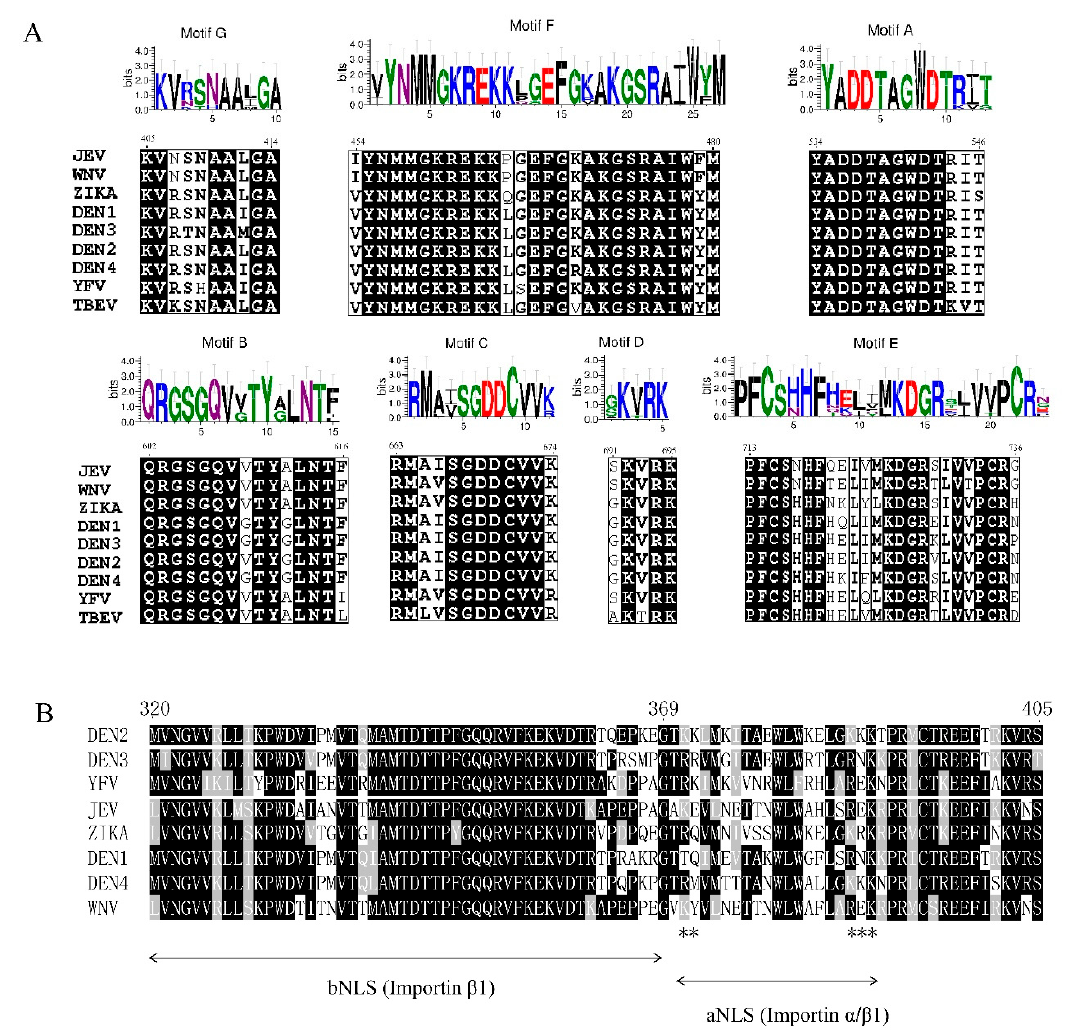
Figure 2. Sequence alignment of flavivirus RdRp domain. ( A ) Sequence alignment of RdRp motifs A to G among di ff erent flaviviruses. ( B ) Sequence alignment of flavivirus bipartite nuclear localization signals. The asterisk shows the key basic residues that serve as functional NLSs.